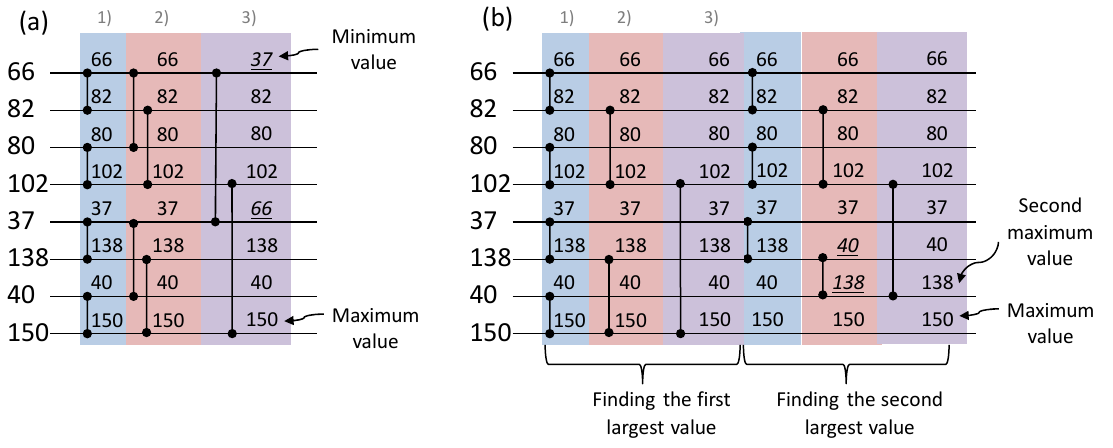
Figure 2. An example of a searching network finding the maximum and the minimum values in a set of 8 input data ( a ); a network of comparators for finding the two largest data items ( b